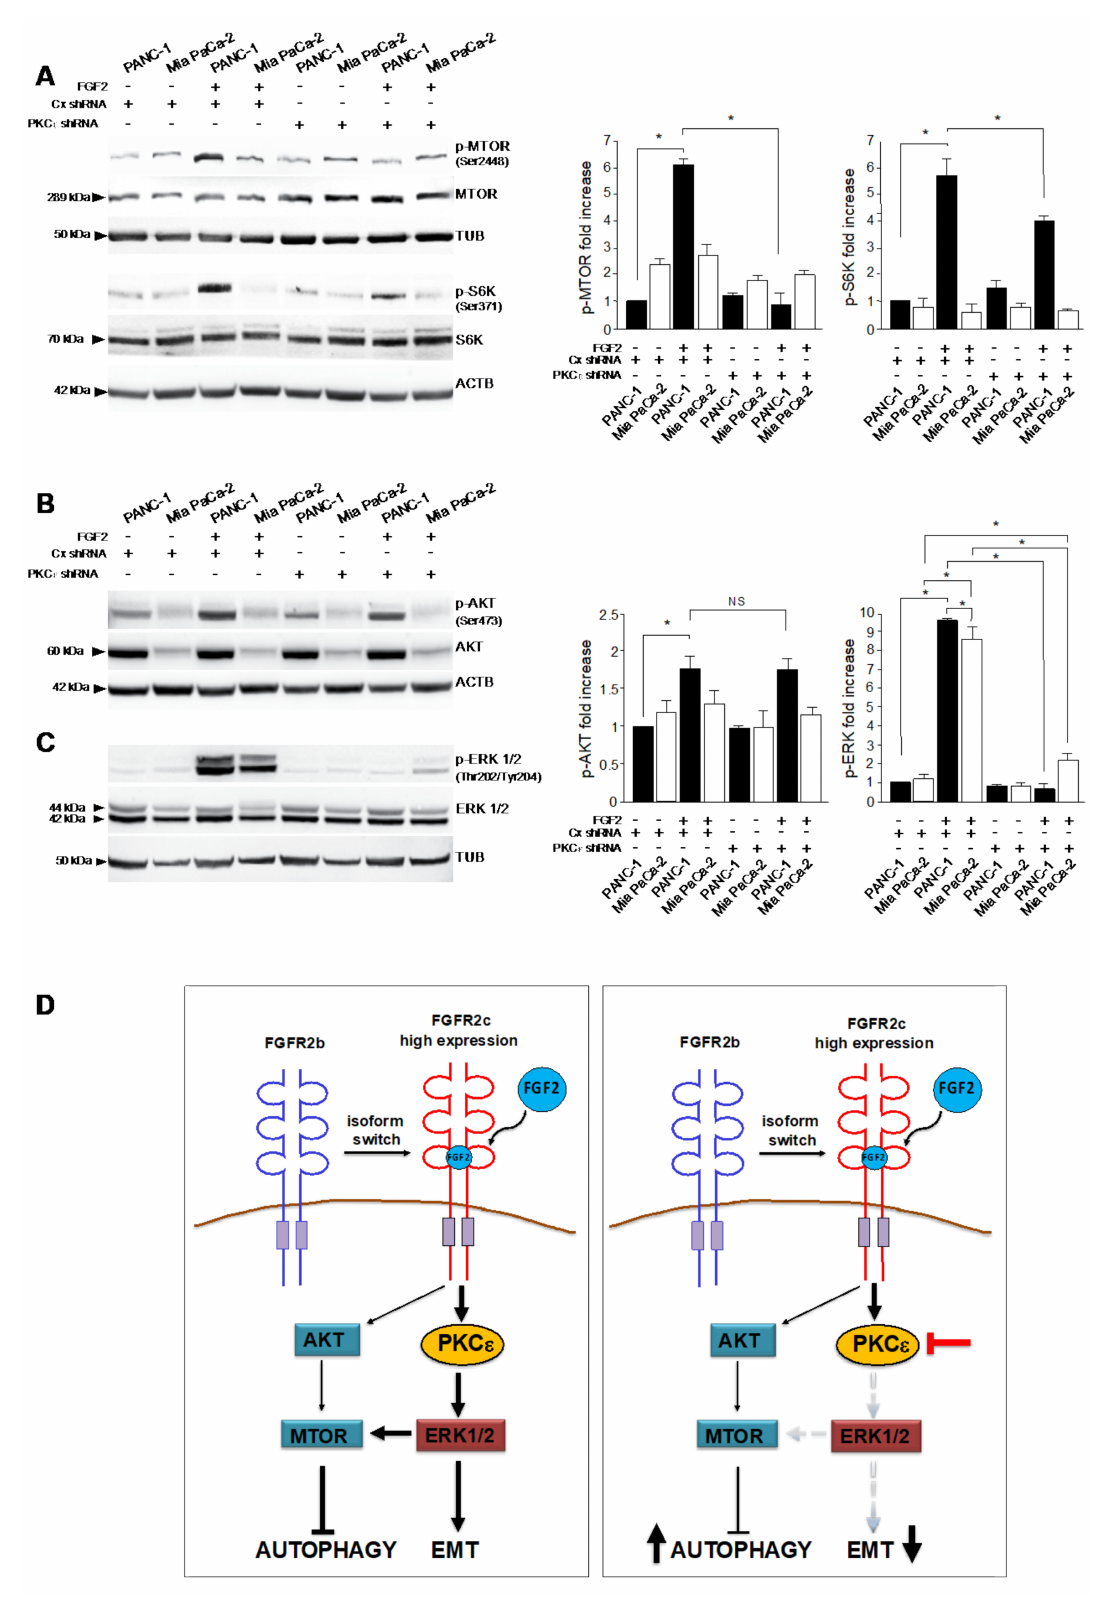
Figure 6. PKC ε signaling shut − off by PKC ε protein depletion interferes with both MTOR and ERK1/2 signaling pathways. PANC − 1 and Mia PaCa − 2 cells stably transduced with PKC ε shRNA or with an unrelated shRNA were left untreated or stimulated with FGF2 as above. ( A ) Western blot analysis shows that the increase of phosphorylation of MTOR and S6K, evident after FGF2 stimulation only in PANC − 1 cells, are strongly dampened by PKC ε knockdown. ( B ) No